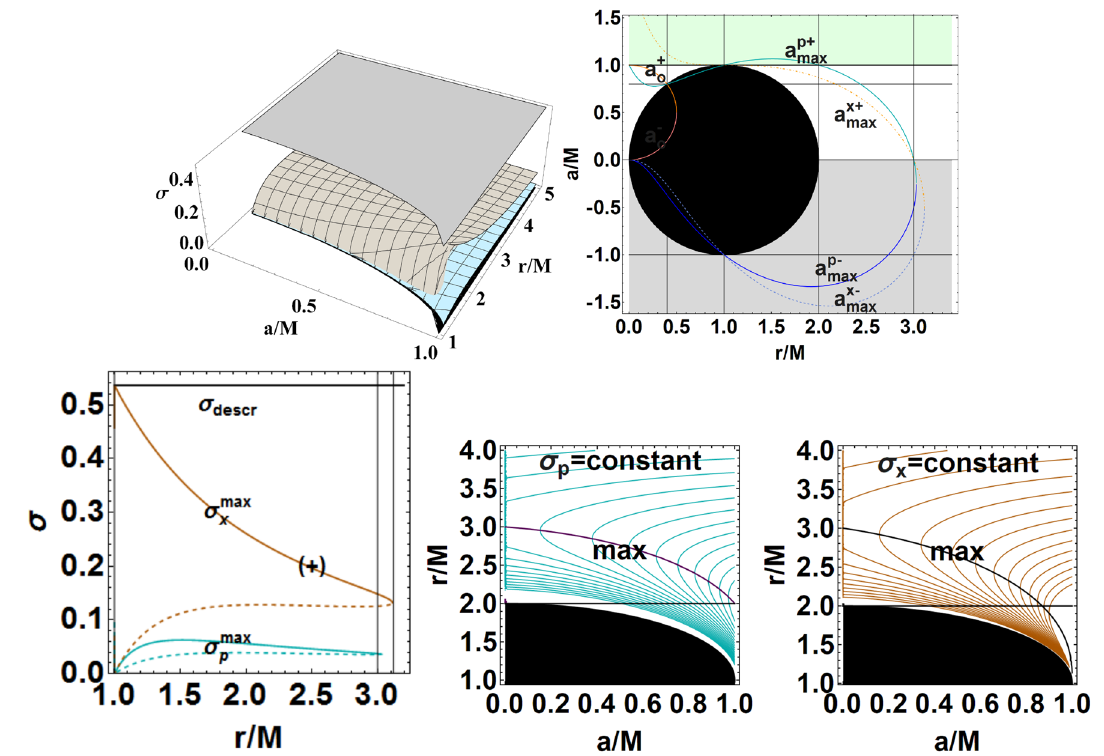
Fig. 20 Analysis of Eqs. (68) and (70) on the confinement of the met- ric bundles with a frequency equal to that of the internal horizon ω − the extended plane. This topic is also addressed in Eq. (60). It is shown that it is always possible to find bundle frequencies ω > 1 (equal to the inner horizon frequencies) in the exterior region as in Fig. 2 for large spin a and small σ . The frequency ω b ≥ 1 refers to a g ∈ [ 0 , 0 . 8 ] , and ω ∈ [ 0 . 5 , 1 [ is related to a ∈] 0 . 8 , 1 ] . Left panel: 3D plot of planes b g σ < σ ∈ [ 0 , M ] and r > M . Planes σ ∈ { 0 , 1 } p x as functions of a Fig. 21 Gray region is the black hole on the extended √ σ . The plane. Here A ≡ a relations between tangent spin and origin spin of the bundles are shown – see Eq. (74). Third panel defines the interior region and the bottleneck region of Fig.